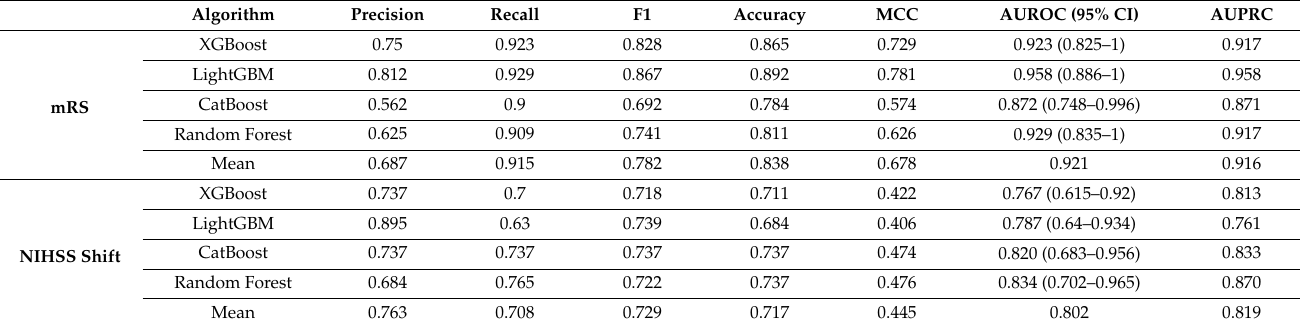
Table 2. Performance metrics of the